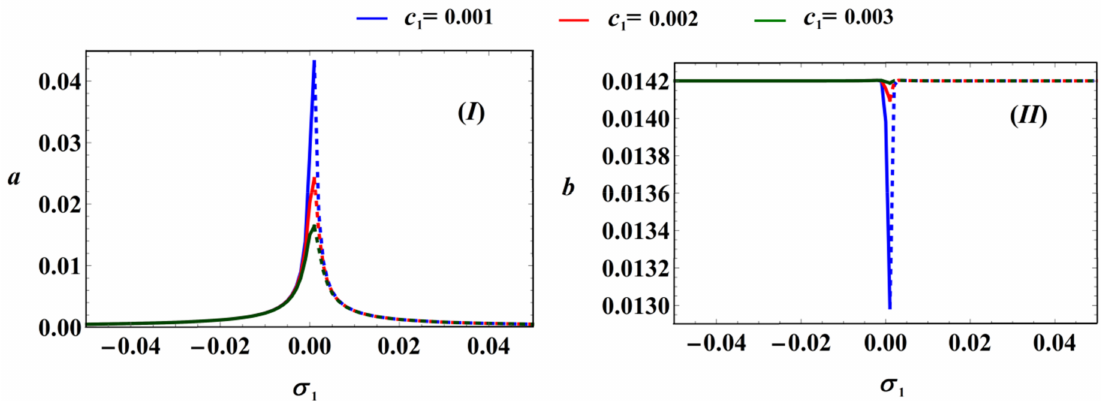
Figure 8. The frequency response at σ 2 = 0, W = 0.448, and c 2 = 0.011 of: ( I ) a ( σ 1 ) and ( II ) b ( σ 1 ) .